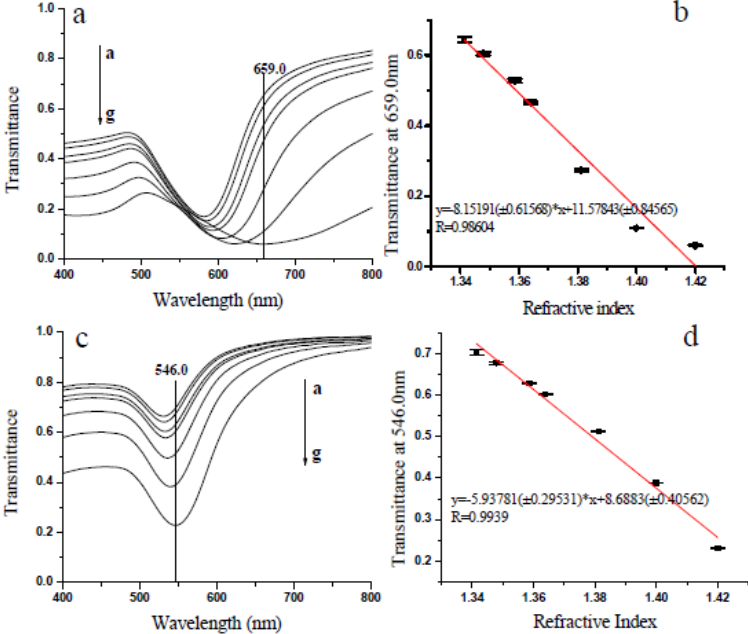
Figure 20. ( a ) and ( c ) Transmission spectra at variable sucrose concentrations by using the 48-nm and 23-nm Au NP films; ( b ) Transmission at 659.07 nm of 48-nm AuNPs as a function of the refractive index value; ( d ) Transmission at 546.0 nm of 23-nm AuNPs as a function of the refractive index value. Reprinted with permission of [73].